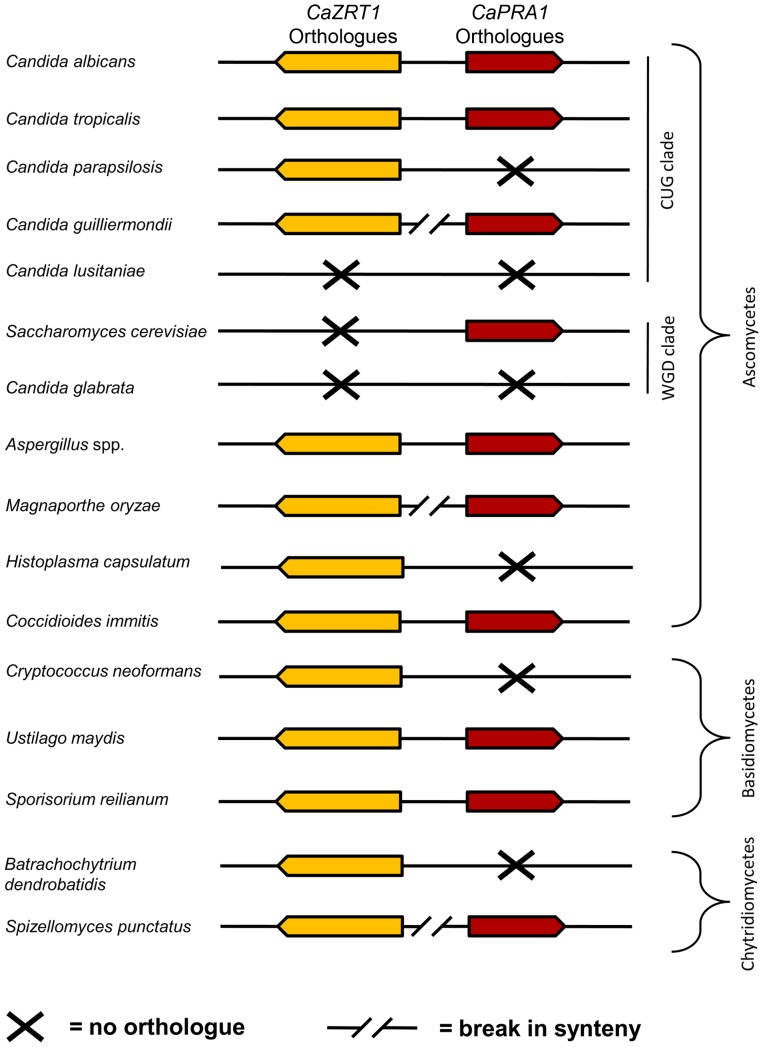
Synteny of genes encoding zinc transporters and zinc-binding proteins.Genomic arrangement of C. albicans ZRT1 and PRA1 orthologues in selected fungal species. Only direct orthologues of C. albicans ZRT1 are shown (CaZrt1-cluster, see Figure S5). Note that synteny is conserved between distantly related species (e.g. C. albicans and U. maydis) but has broken down in more closely related species (e.g. C. albicans and C. parapsilosis).